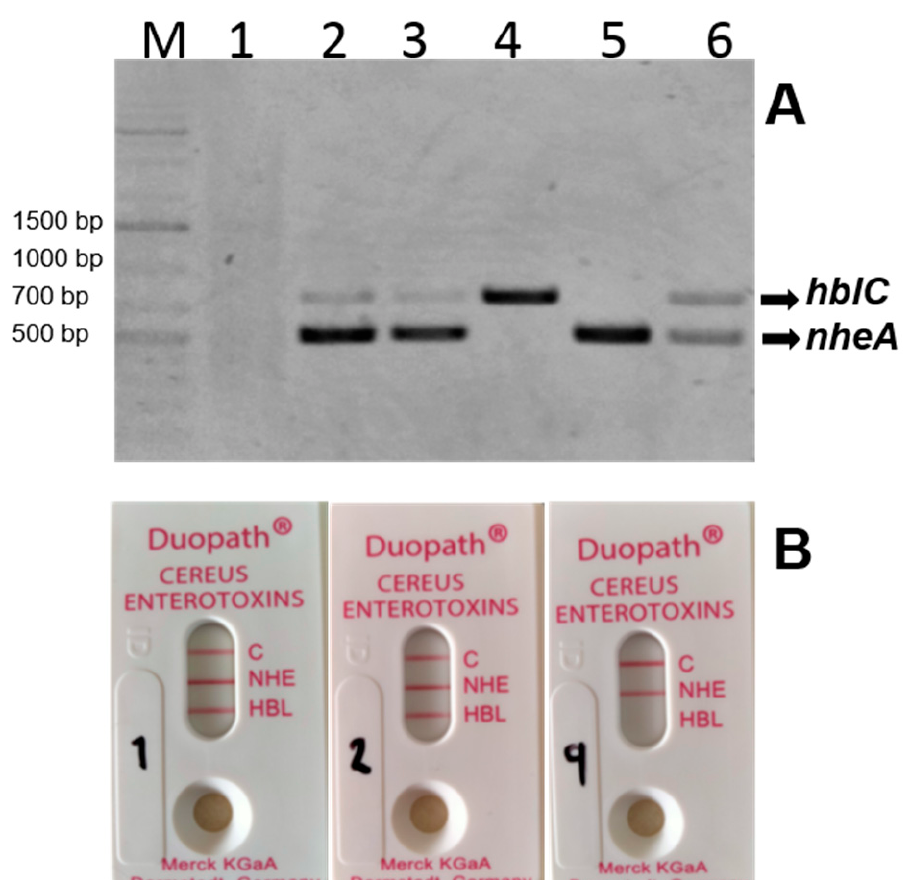
Figure 3. Representative results for toxigenic characteristics. Panel ( A ) shows a representative electrophoresis gel for multiplex PCR. Lane M contains a Thermo Scientific GeneRuler 1 Kb DNA ladder, lane 1; strain SA5-1, lane 2; strain SA, lane 3; strain SB-2, lane 4, 5, and 6 is the control ( B. cereus ATCC 10876) with single or multiplex PCR respectively. The arrows show the PCR amplification product for hblC (750 bp) and nheA (500 bp) toxin genes. Panel ( B ) shows a representative Duopath test for detection of toxin production indicated by a red line in both the test (Nhe and/or Hbl) and control zones (C). From left to right; B. cereus ATCC 10876 (1), SA75-1 (2), and SD20-1 (9).